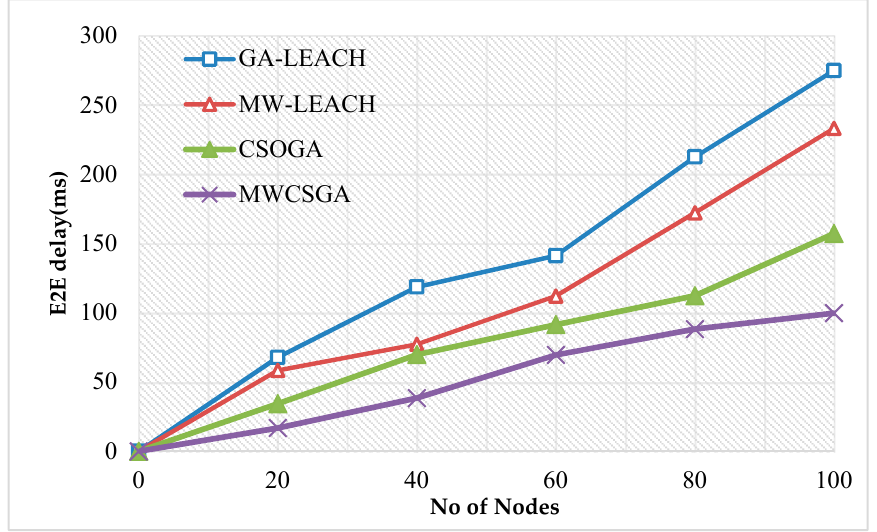
Figure 11. End to end delay calculation.